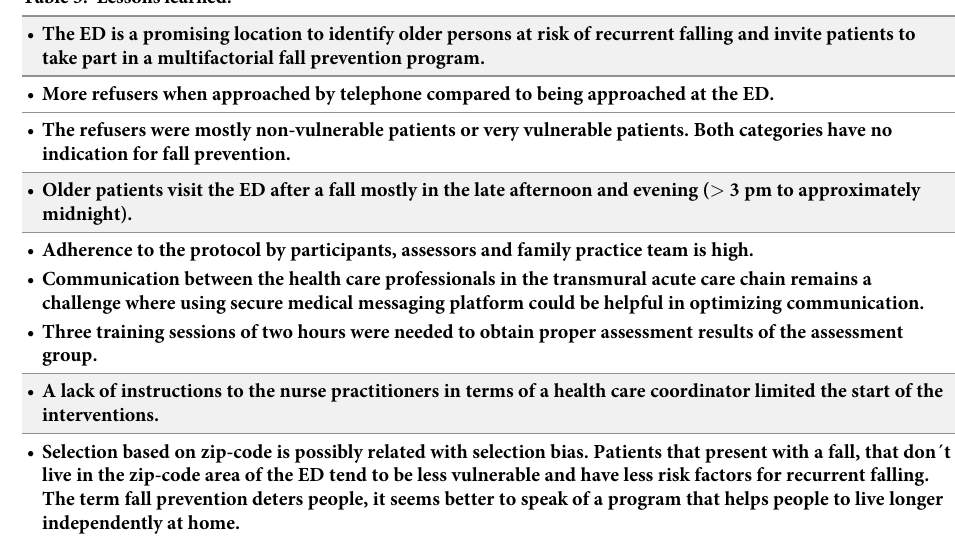
Fig 3. An overview of the prevalence of triggered CAPs among older people who received an interRAI-HC assessment in primary care. https://doi.org/10.1371/journal.pone.0268682.g003 Table 3. Lessons